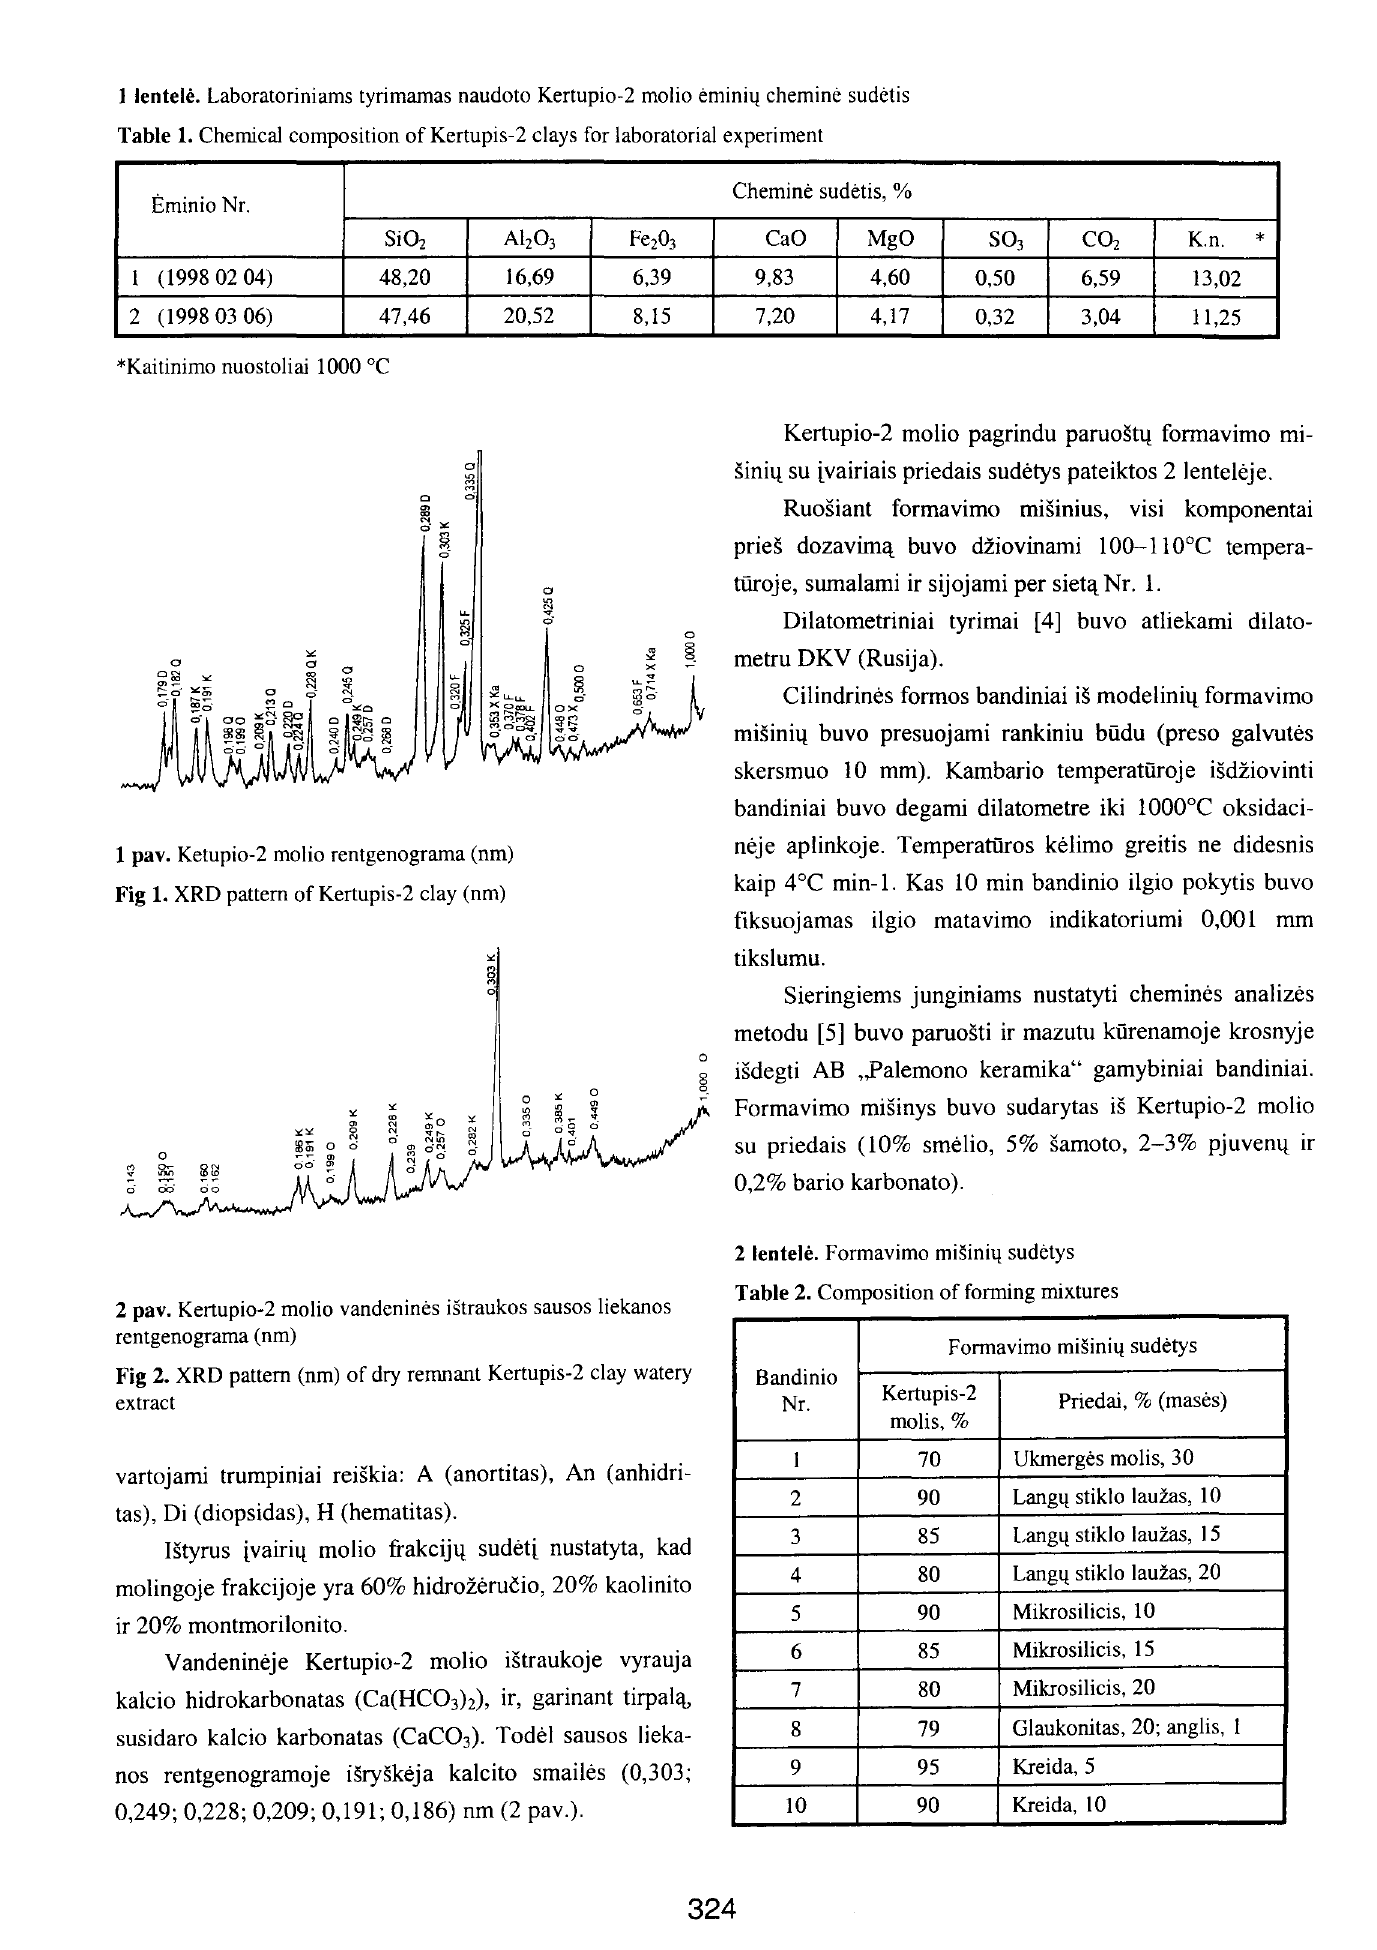
Table 1. Chemical composition of Kertupis-2 clays for laboratorial experiment Eminio Nr.